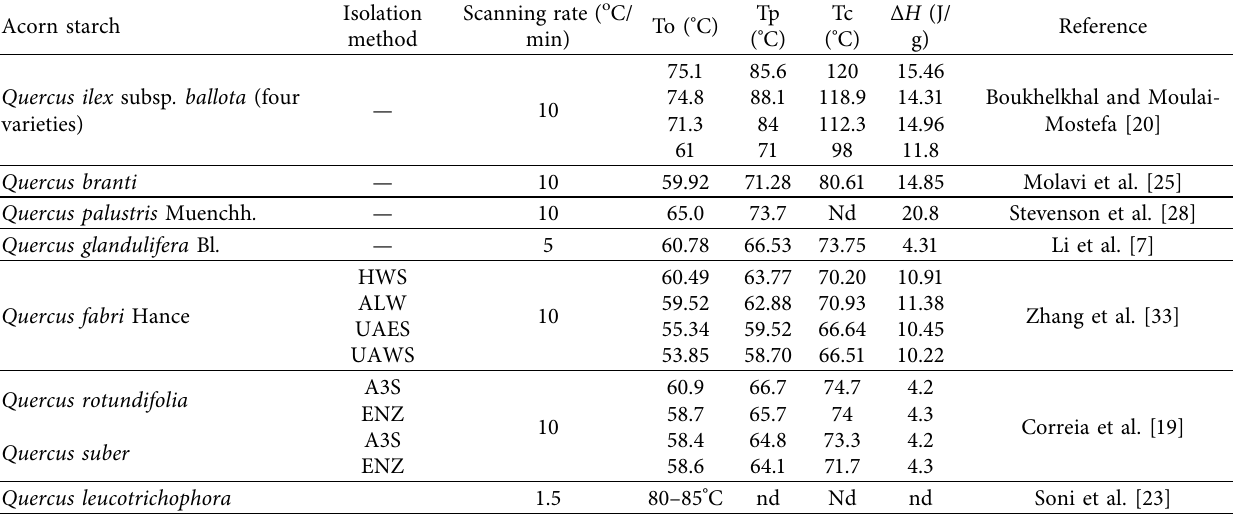
Table 3: Gelatinization properties of acorn starch.